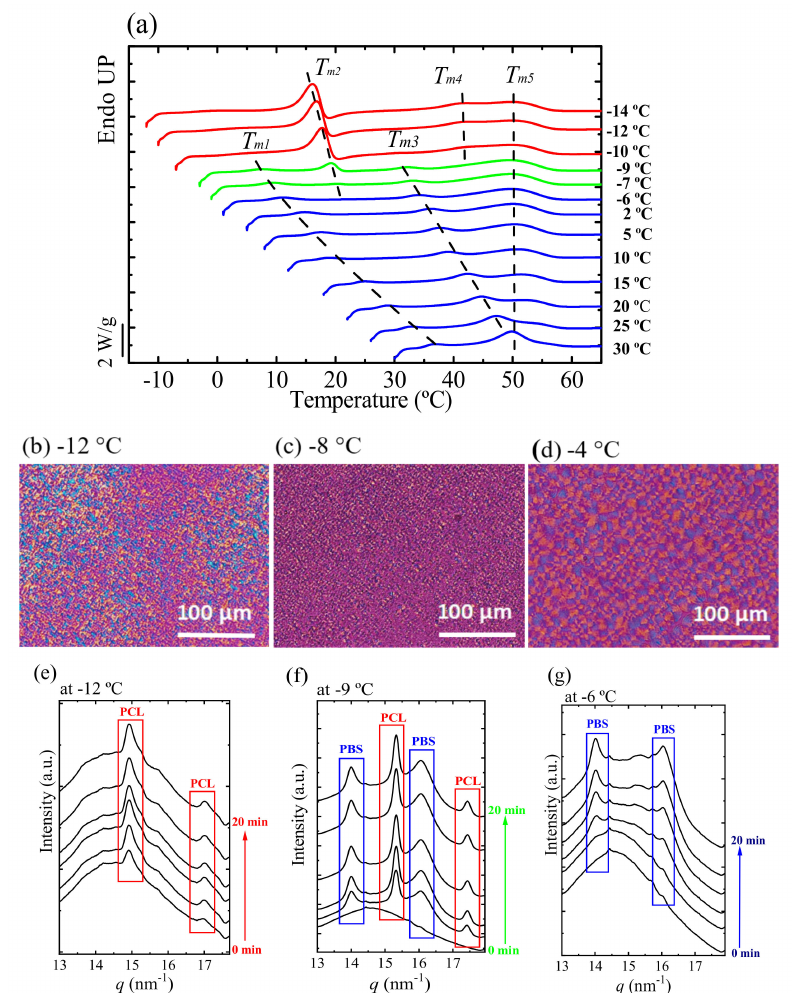
Figure 9. ( a ) DSC heating scans (10 ◦ C/min) after isothermal crystallization at indicated different temperatures for MM W -BS 45 CL 55 -copolyester. PLOM micrographs taken after isothermal crystal- lization at − 12 ◦ C ( b ), − 9 ◦ C ( c ) and − 4 ◦ C ( d ). WAXS patterns of the sample at the pseudo-eutectic point recorded during isothermal crystallization at − 12 ◦ C ( e ), − 9 ◦ C ( f ) and − 6 ◦ C ( g ). See ref. [38] for more